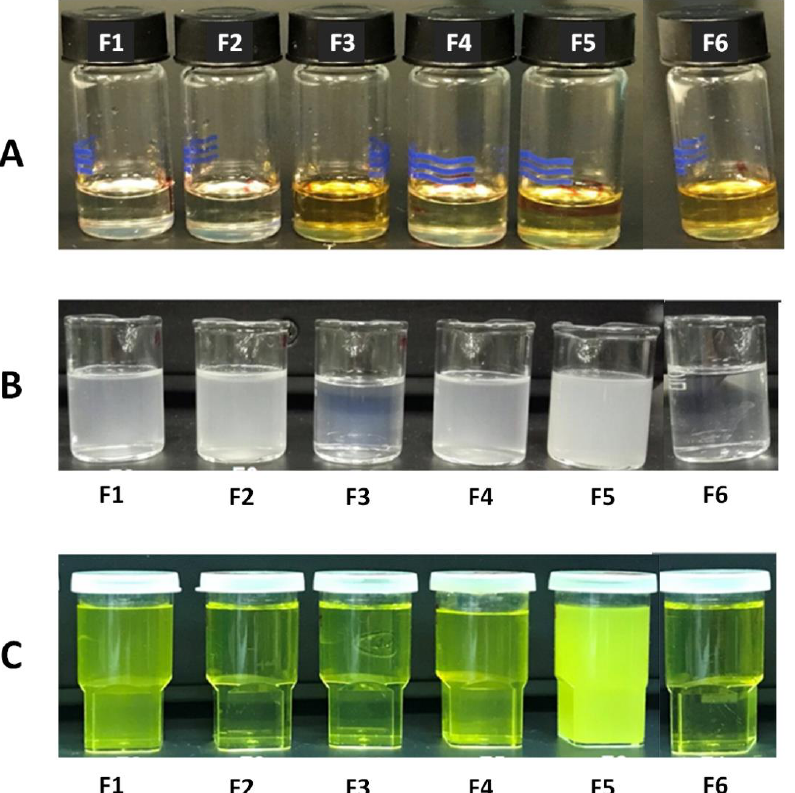
Figure 2. Appearance of ( A ) anhydrous SNEDDS after loading with CUR and PP, ( B ) drug-free SNEDDS after 1:100 aqueous dilution and ( C ) CUR-PP loaded SNEDDS after 1:1000 aqueous dilution.